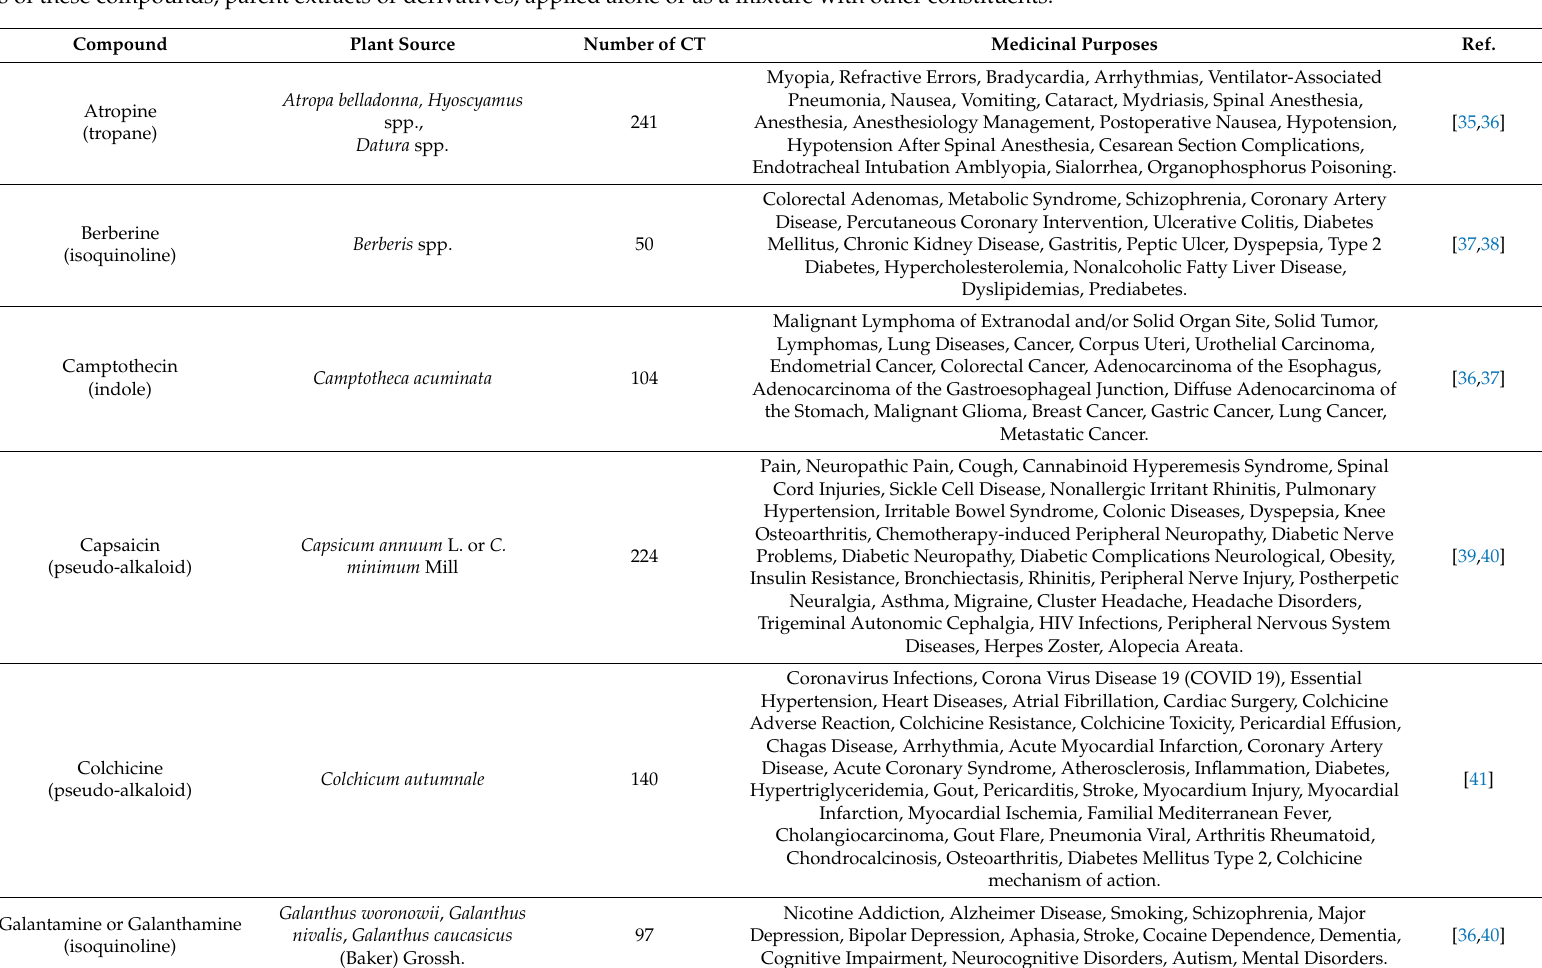
Table 1. Plant-derived alkaloids in clinical trials (CT). Includes not yet recruiting, recruiting, enrolling by invitation, active not recruiting, suspended and completed trials of these compounds, parent extracts or derivatives, applied alone or as a mixture with other